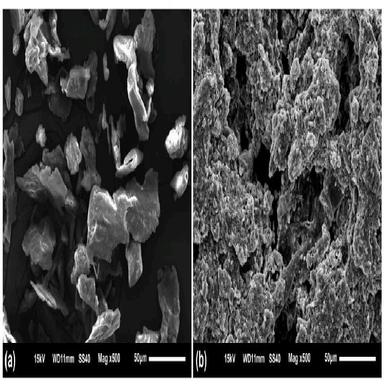
SEM images from (a) CS and (b) CS-TSe.